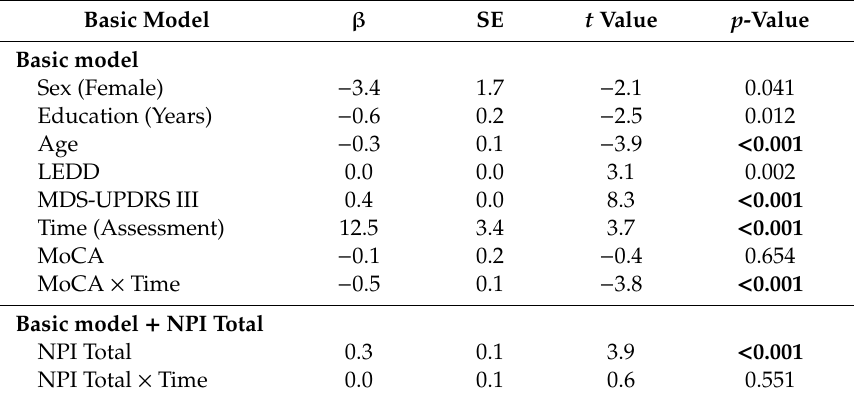
Table 3. Predictors of change in quality of life (PDQ-39) using mixed-e ff ects